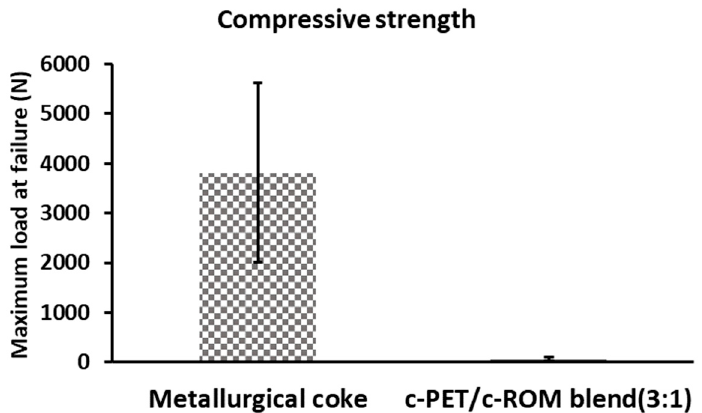
Figure 12. Bar graph comparing the compressive strength results obtained for commercial metallurgical coke and c-PET/c-ROM composite. The results are only based on the maximum load at failure.